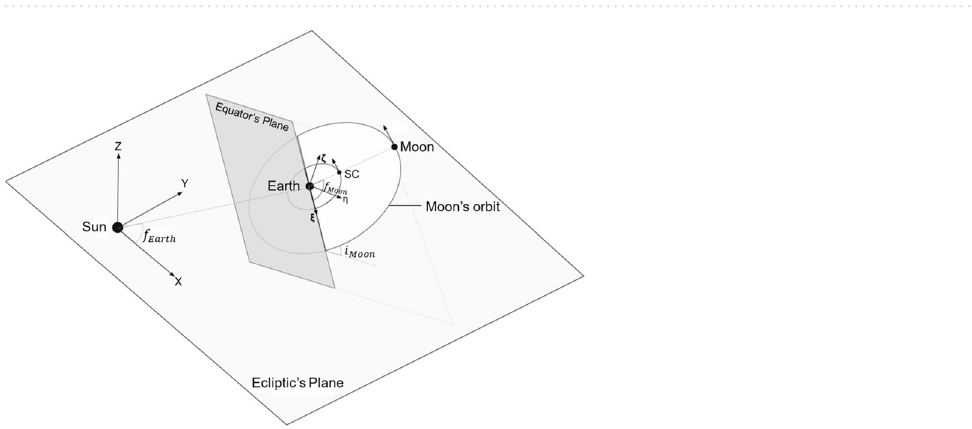
Figure 1. ( a ) Periodic orbit of family G and ( b ) trajectory G of escape in the inertial geocentric reference frame.